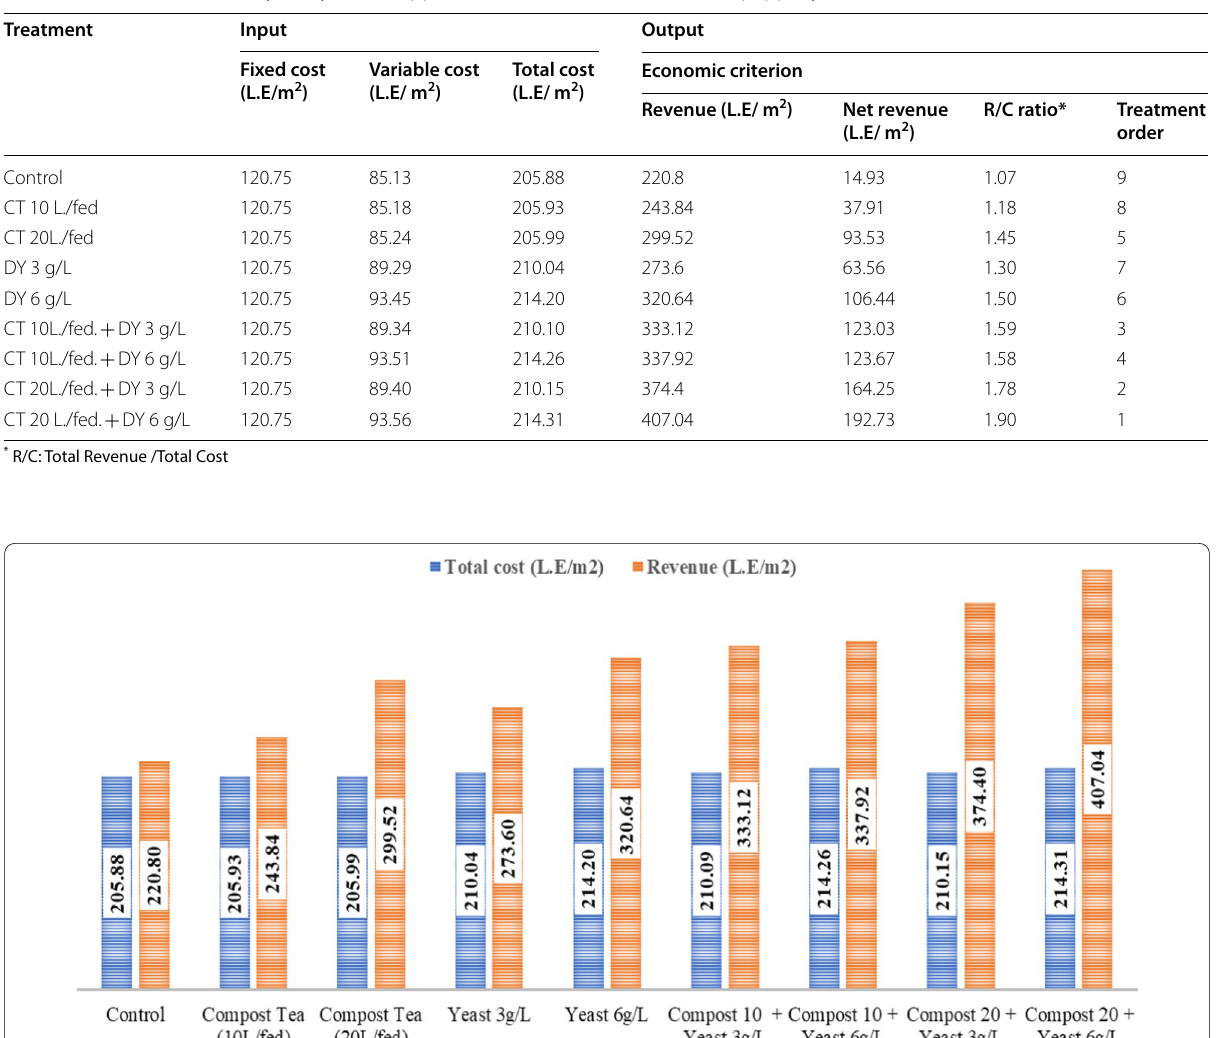
Table 11 Economic feasibility study for the application of different treatments on pepper yield (L.E./ m 2 ) Treatment